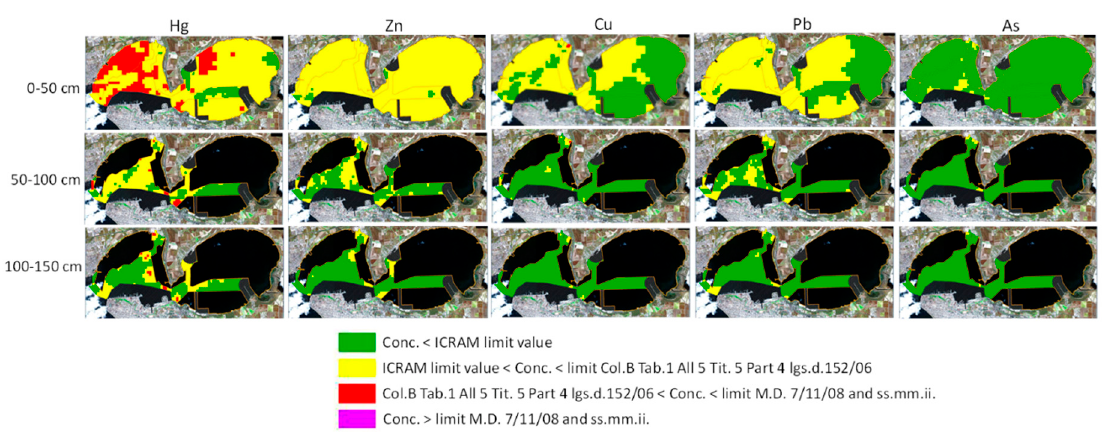
Figure 7. Inorganic compound concentrations map (adapted from [42]).